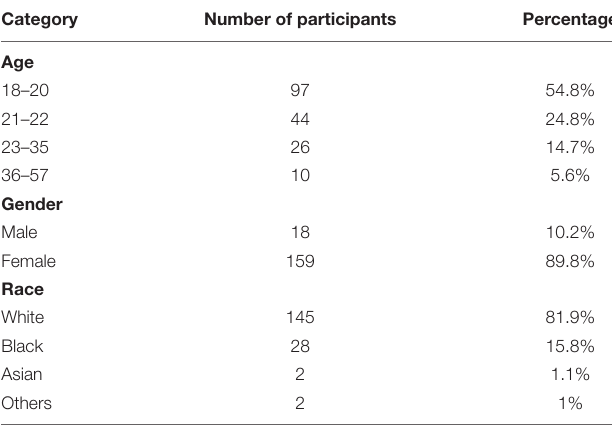
TABLE 1 | Demographic